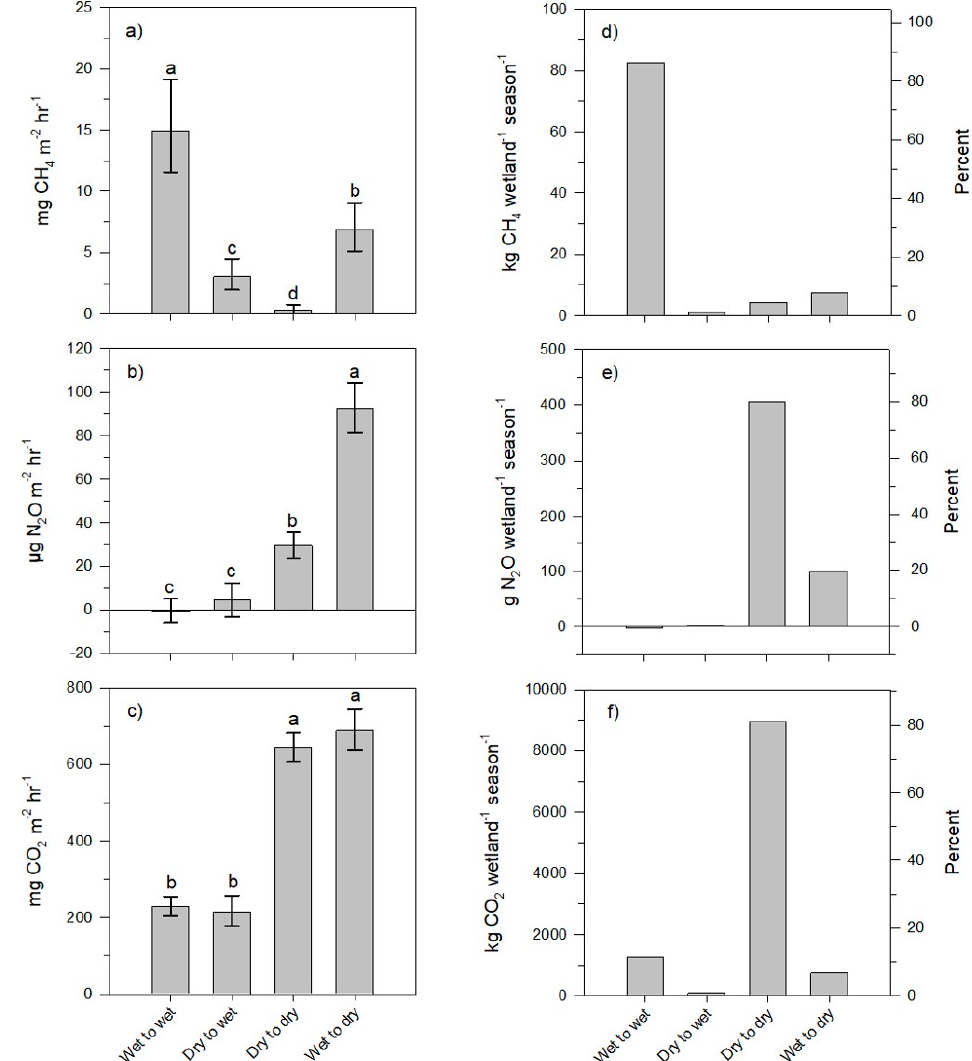
Figure 3. Average (least square means ± 95% confidence intervals) fluxes of ( a ) CH 4 , ( b ) N 2 O, and ( c ) CO 2 of seasonal Prairie Pothole Region wetlands by hydrologic state. Average area-adjusted, cumulative fluxes of ( d ) CH 4 , ( e ) N 2 O, and ( f ) CO 2 of seasonal Prairie Pothole Region wetlands by hydrologic state. For panels a–c, different letters indicate significant differences among the hydrologic states ( α = 0.05).